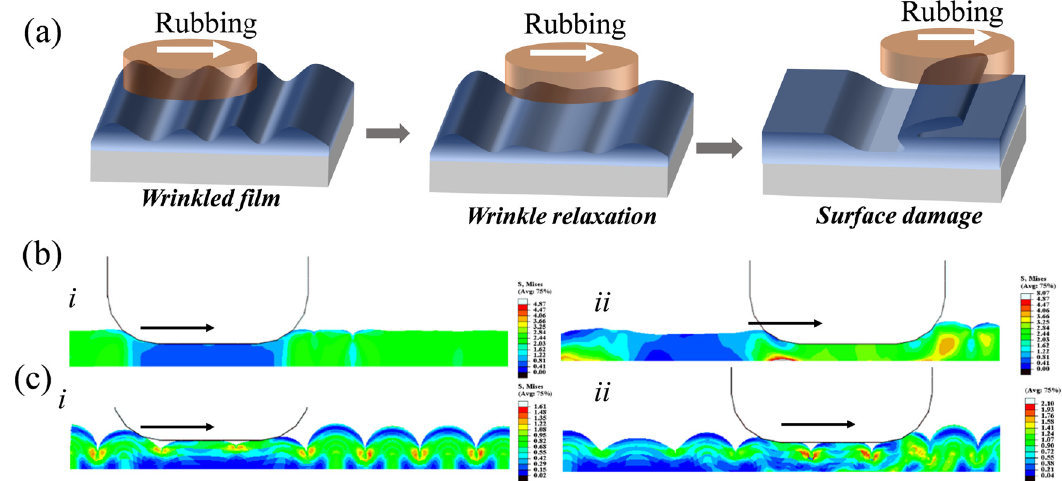
Figure 4: ( a ) Failure process diagram of PDMS fi lm surface; simulation of stress distribution and damage behavior of ( b ) plat fi lm and ( c ) wrinkled PDMS fi lm in abrasion